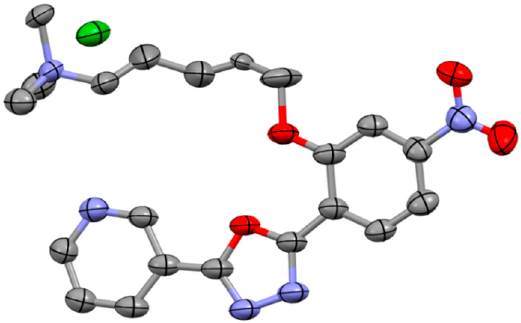
Figure 2. Molecular structure of C1•Br. Thermal ellipsoids are drawn at 50% probability level. Atoms are color-coded as follows: carbon (gray), oxygen (red), nitrogen (blue), bromine (green).